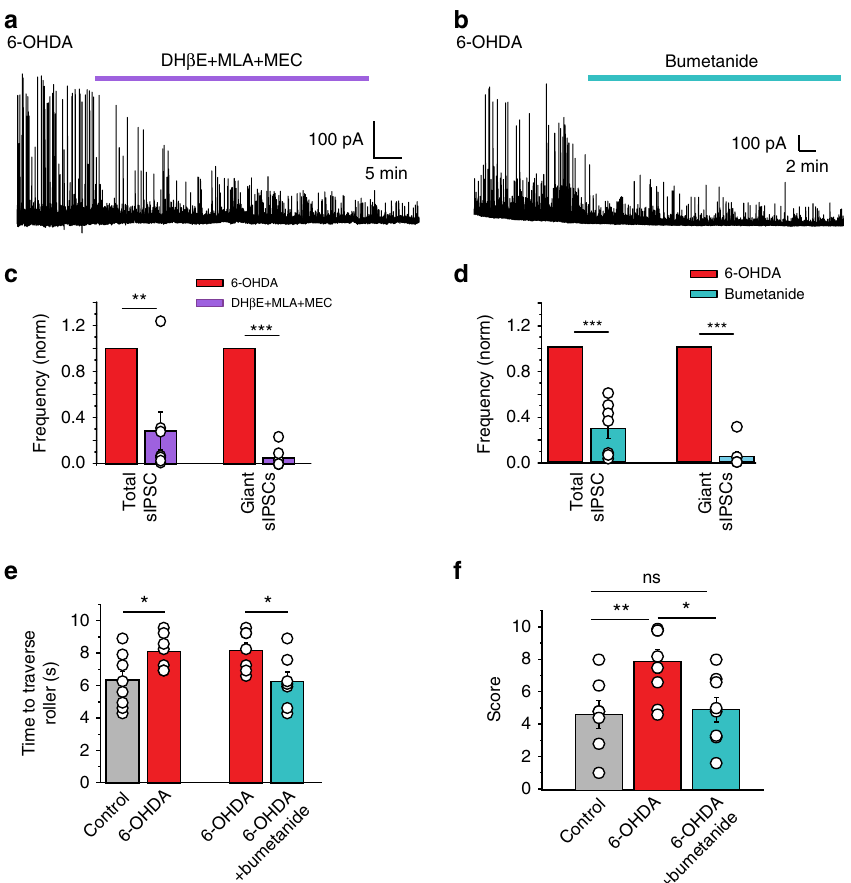
Fig. 6 Bumetanide attenuates electrical network and behavioral effects of dopamine deprivation. Nicotinic receptor antagonists a , c or bumetanide b , d treatment blocked giant GABAergic PSCs recorded in SPNs (6-OHDA-treated mice) at V H = + 10 mV. e , f Behavioral tests. e Time to traverse roller in control and 6-OHDA-treated mice (same 6-OHDA-treated mice before and after bumetanide treatment). f Pole test score of the three different mouse groups. See Supplementary Movies 2-7. All means ± SEM. c , d Signi fi cance was determined by two-tailed, paired Student ’ s t-test; see Supplementary Tables 19 and 20 for statistics. e Signi fi cance was determined by two-tailed unpaired (left set) or paired (right set) Student ’ s t -test; see Supplementary Table 21 for statistics. f Data sets were analyzed using one-way ANOVA followed by Fisher ’ s least signi fi cant difference (LSD) post-hoc test; see Supplementary Table 22 for statistics; * P < 0.05, ** P < 0.01, *** P < 0.001. NS, not signi fi For triple-labeled EGFP + -ChAT-Lhx6 cells detection, images (pixel size 0.321 2 – 3µm and a resistance of 0.7 – 1.5M Ω when fi lled (3 – 5µL) with the “ low ” chloride µm) were acquired on a Zeiss LSM 800 confocal laser-scanning microscope (Carl intracellular solution prepared with RNAse-free water (Roche, USA) and con- Zeiss) using the 488, 555, and 647nm lasers for excitation of EGFP, CY3, and taining 1000 units per mL of Protector RNase Inhibitor (Roche). Cytoplasm and Alexa Fluor 647 (spectral detection, 400 – 550nm, 550-630 nm, and 630-700 nm, nucleus of identi fi ed EGFP + cells were collected into the patch pipette under visual respectively). We used the × 40 objective (NA 1.4) and sequentially scanned each control. Appropriate controls for possible DNA and RNA contamination were channel with a frame average 2. For ChAT, VGAT, and GAD65-67 performed when harvesting cells, Reverse Transcription and qPCR reaction: (i) RT- immunostaining, images were acquired on a confocal laser scanning microscope q PCR was performed in individual cells (not pulled data set, as typical practice for Leica TCS SP5X equipped with a white light laser, a 405 nm diode for ultraviolet these studies) to avoid false positive result due to contamination; (ii) SPNs were excitation, and 2 HyD detectors, using the × 63 objective, and the 568 nm and 647 used as negative control; (iii) water was tested instead of cell DNA in the RT-qPCR nm wavelength for ChAT and VGAT or GAD65-67, respectively. mix to check contamination in the RT-qPCR mix; (iv) samples with no reverse For biocytin- fi lled cell reconstructions, confocal images (pixel size 0.240 µm) transcriptase to check DNA contamination in the reverse transcription mix; (v) were acquired on a SP5X Leica microscope (Leica Microsystems) using the 555 nm pipette immersed in slice without patching and then same procedure to check band of a white laser for excitation of Alexa Fluor 555 (spectral detection, 565 – 675 contamination in the pipette solution and the medium of recording. nm). Images were acquired at 400 Hz using a ×63 oil-immersion objective, pinhole The content of the patch pipette was expelled into 11.4 μ L of re-suspension set to “ Airy 1 ” , by scanning with a z step of 0.50 μ m. buffer containing 20 units of Protector RNase Inhibitor and 60 µM random hexamer primer (Roche). After 10 min of denaturation at 65 °C, reverse transcription was performed using Transcriptor high- fi delity cDNA synthesis kit Reconstruction of biocytin- fi lled neurons and Sholl analysis . Only neurons with (Roche) on a SimpliAmp Thermal Cycler (Applied Biosystems, USA) following the a complete dendritic arbor were analyzed. Stacks were imported in the open-source kit procedures and then kept on ice until the PCR analysis. The PCR analysis was platform Fiji (https:// fi ji.sc/) and stitched together (https://imagej.net/ conducted using the LightCycler 480 Real-Time PCR System (Roche) in a total Image_Stitching) 51 . Without any additional pre-processing, dendrite and axon volume of 15 µL containing 3.75µL of template DNA, 7.5µL LightCycler 480 reconstructions, as well as morphological metric measurements were performed Probes Master (Roche), and 1.5µL of selective Taqman ® gene expression assay for using the semi-automated “ Simple Neurite Tracer ” plugin (http://imagej.net/ ChAT or GAD65 , or Lhx6 or Lhx7 mRNAs with hypoxanthine Simple_Neurite_Tracer) 52 . Based on dendrites reconstructions, a Sholl analysis was phosphoribosyltransferase ( HPRT ) mRNA (Life Technologies). HPRT was used as performed using “ Sholl Analysis ” plugin (http://imagej.net/Sholl_Analysis) 53 . housekeeping or reference gene (see Supplementary Table 23 for speci fi c references), because its expression level is close to that of the target genes in the cell of interest. The reactions were subjected to an initial incubation at 95 °C for 10min, Single-cell RT-qPCR . Single-cell RT-qPCR was performed according to modi fi ed followed by 50 cycles of 95 °C for 10s, annealing and extension for 40s at 60°C. protocols described in ref. 54 . Sterile patch pipettes had a tip outer diameter of ~